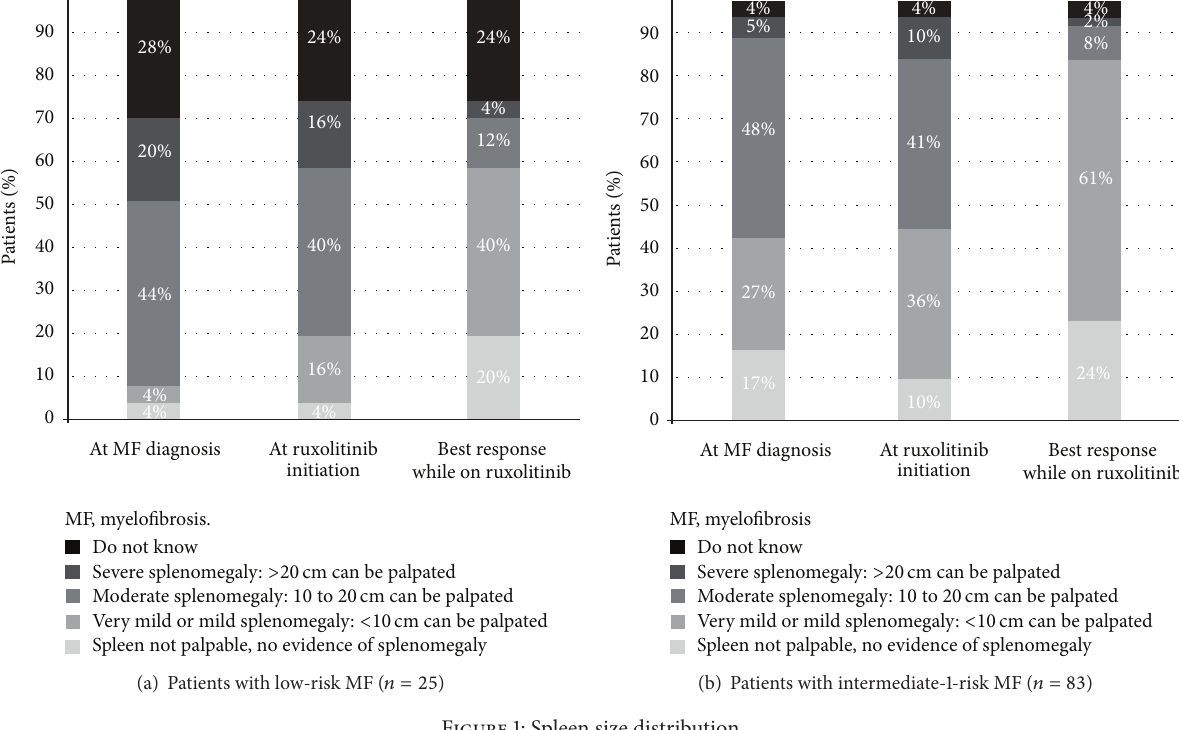
(b) Patients with intermediate-1-risk MF ( 𝑛 = 83 ) Figure 1: Spleen size